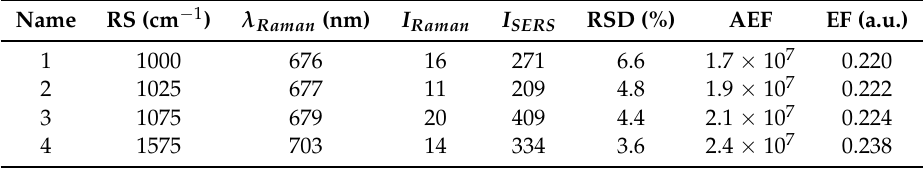
Table 1. For the excitation wavelength of 633 nm and four Raman peaks (RS) studied here, λ Raman associated to RS, the intensities I Raman and I SERS , RSDs associated to I SERS values, analytical enhancement factors (AEF) and EF values (in arbitrary unit) obtained with the E 4 model are